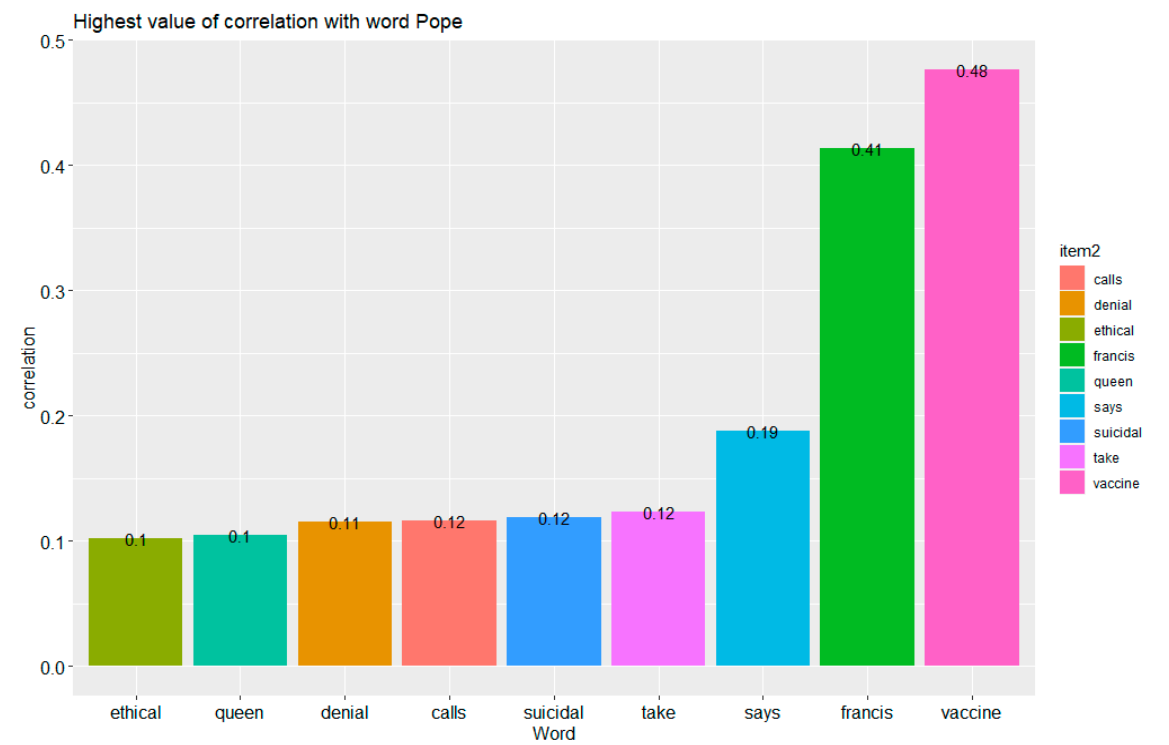
Figure 7. The highest correlations with the word pope. Made using ggplot2 and widyr in R.